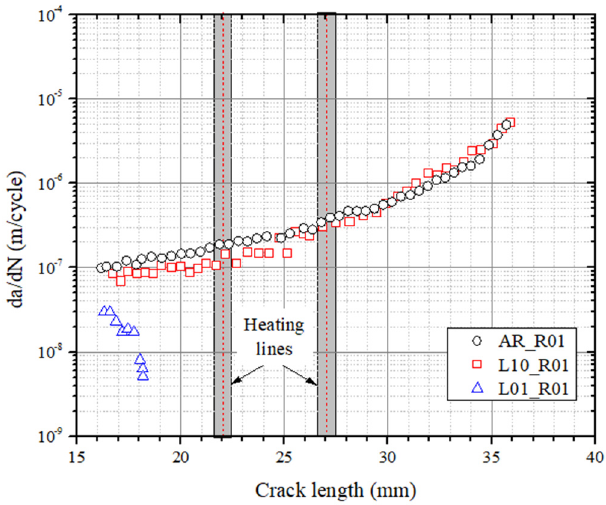
Figure 6. Crack growth rate vs. crack length for R = 0.1 tests.